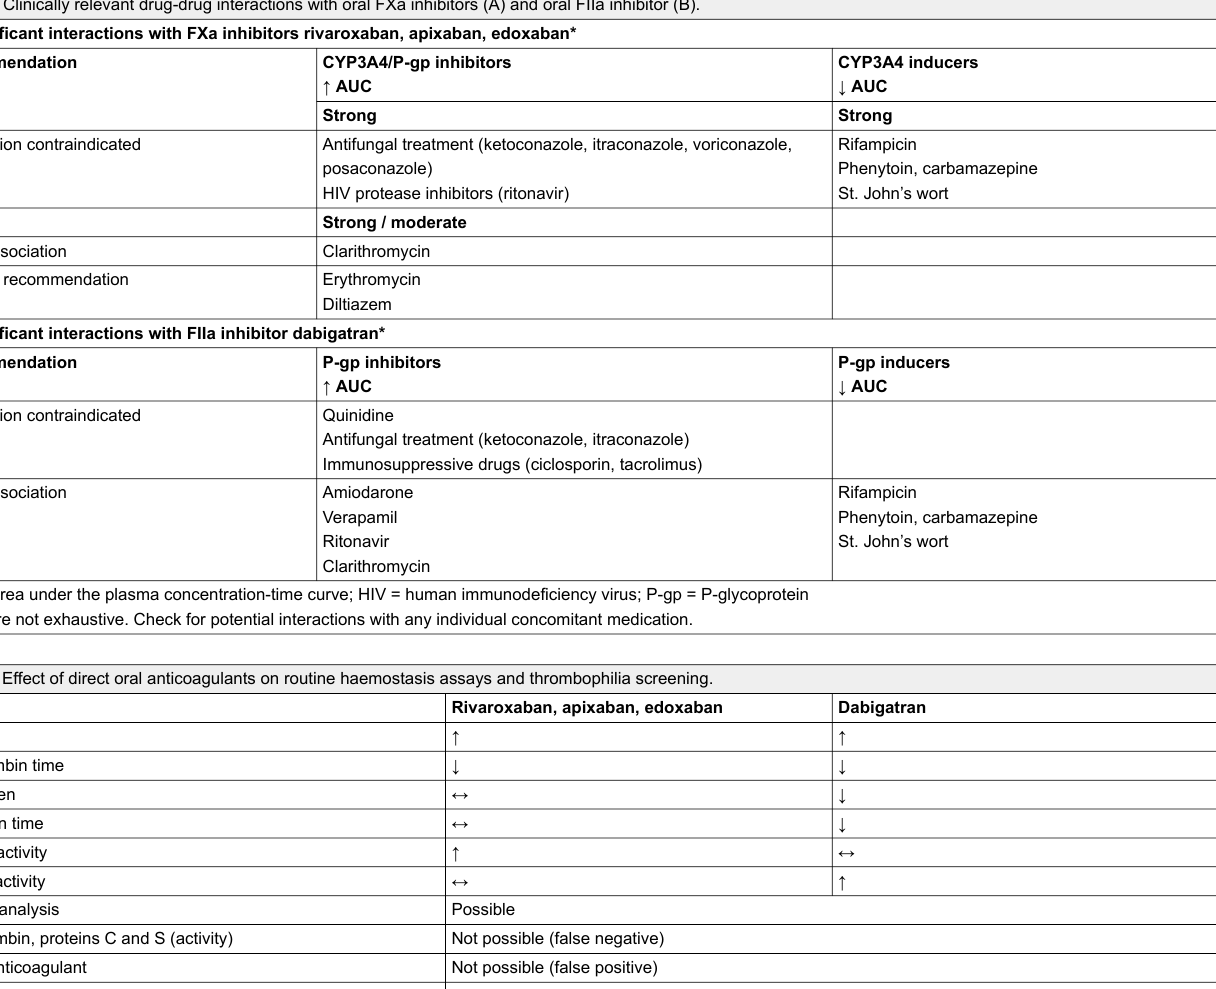
Table 3: Clinically relevant drug-drug interactions with oral FXa inhibitors (A) and oral FIIa inhibitor (B). A. Significant interactions with FXa inhibitors rivaroxaban, apixaban, edoxaban*